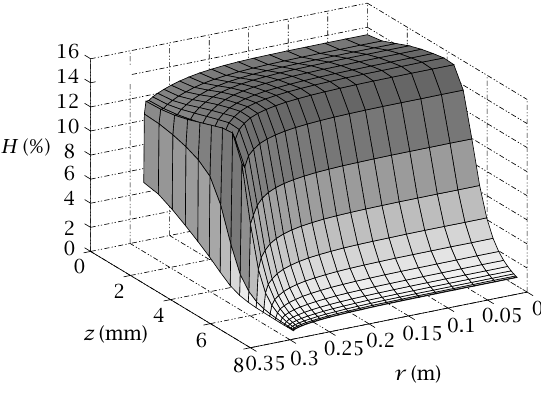
Figure 5.10 . 3D view for moisture content at t =